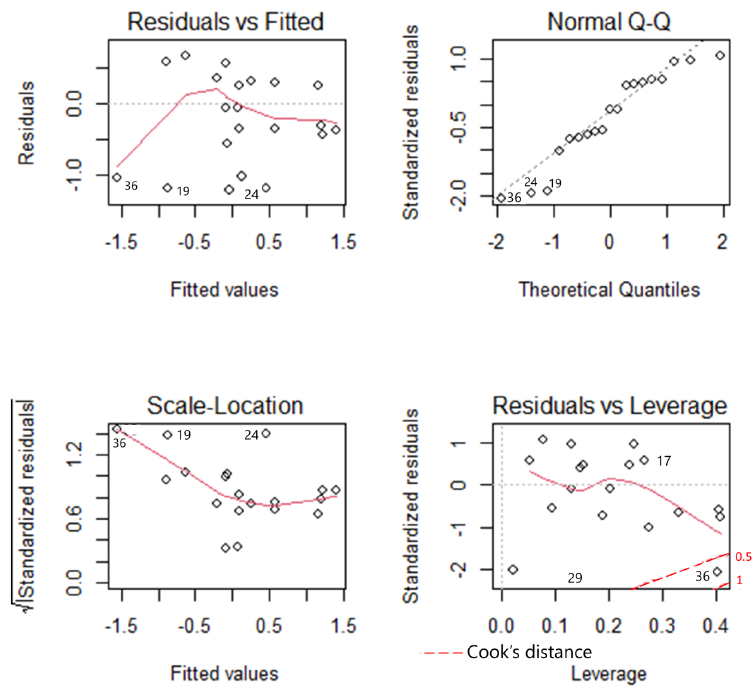
Figure A5. Model diagnostics for the best model with overall spring AA as the explained variable, and 15 climate variables and the Year as explanatory variables for the Common Whitethroat Curruca communis (Table A14).